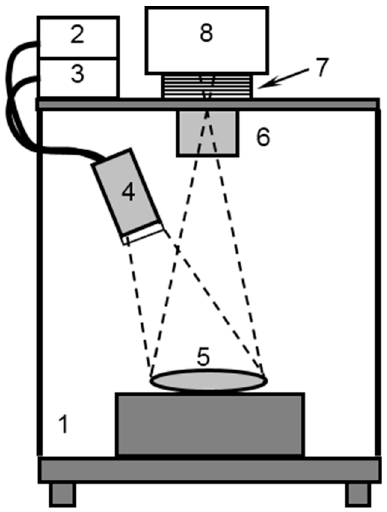
Figure 1. Schematic of the experimental setup for fluorescence imaging: 1—dark chamber, 2,3—laser sources 690 and 785 nm, 4—optical diffusor, 5—experimental object, 6—objective lens, 7—filter wheel, 8—CCD.